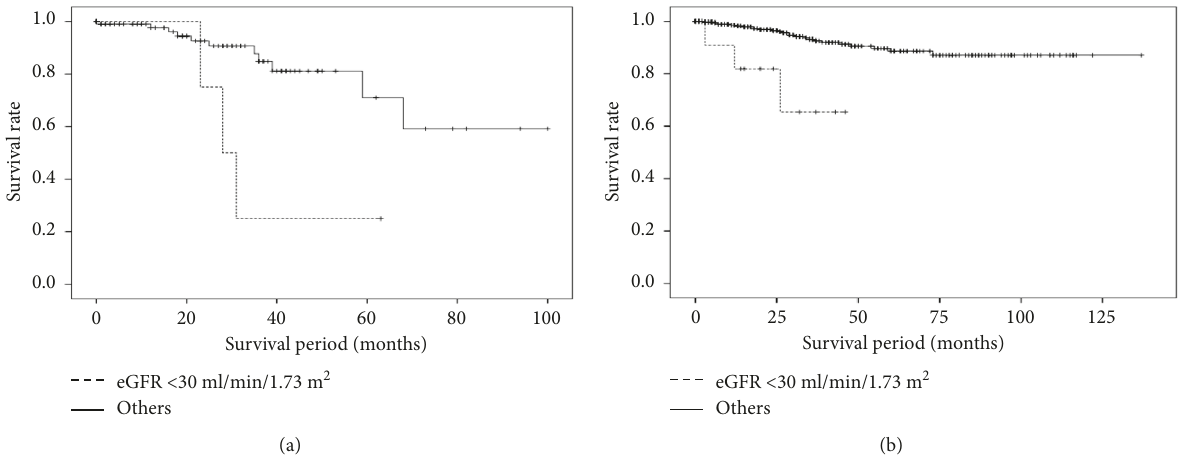
Figure 2: Comparison of the survival rate between patients whose estimated glomerular filtration rate (eGFR) was < 30ml/min/1.73 m 2 and other patients in the elderly and nonelderly groups. (a) Elderly group. The mean survival time periods were 36.3 ± 7.9 and 78.2 ± 6.1months among patients whose eGFR was < 30ml/min/1.73 m 2 and among other patients, respectively ( P < 0 . 05, log-rank test). (b) Nonelderly group. The mean survival time periods were 35.7 ± 5.0 and 124.1 ± 2.6months among patients whose eGFR was < 30ml/min/1.73 m 2 and among other patients, respectively ( P < 0 . 05, log-rank